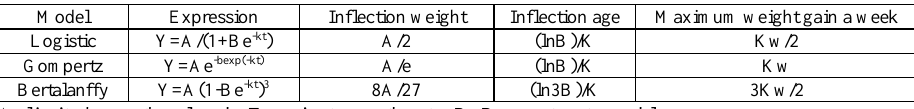
Table 1. Mathematical description and biological parameters of three common used nonlinear growth models.